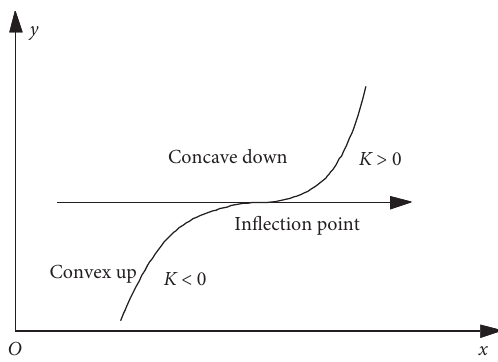
Figure 2: The relationship between terrain change and curvature.